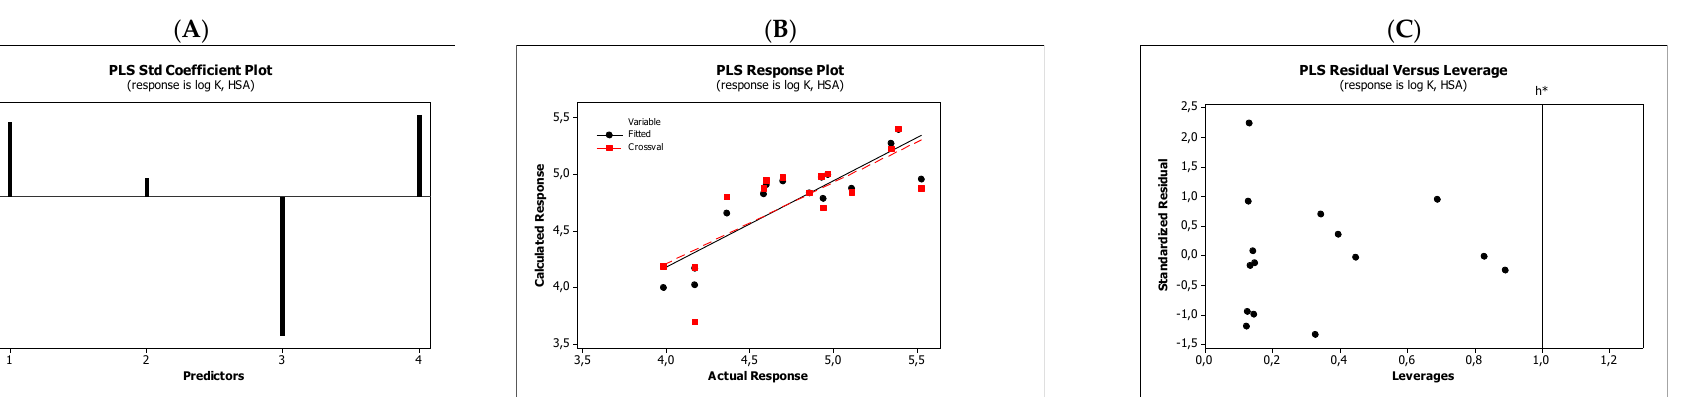
Figure 8. Standardized coefficients ( A ), the correlation between actual and predicted log K a, HSA parameters ( B ), and the Williams plots ( C ) of Equation (7).